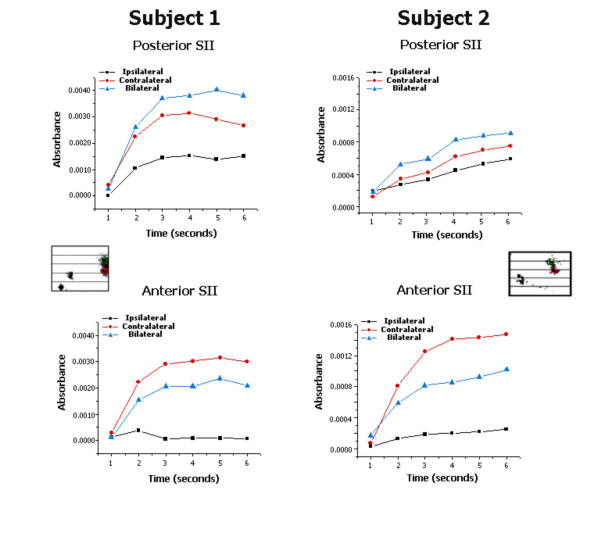
Graphs obtained from OIS data in the anterior and posterior SII cortical regions evoked by flutter stimulus on the central pad of 2 subjects. Figurines indicate regions of interest. (A) Top Panels: Time course of absorbance values from the posterior SII region obtained with ipsilateral, contralateral, and bilateral stimulus. Note that in this case, the absorbance evoked by the bilateral stimulus is larger than the response evoked by either the ipsilateral or the contralateral stimulus. (B) Bottom Panels: Time course of absorbance values from the anterior SII region obtained from data sampled during ipsilateral, contralateral, and bilateral stimulation. Note that the response evoked by the bilateral stimulus is smaller than the response evoked by the contralateral stimulus. Maximal differentiation of the time course of the response to the different stimulus conditions appears to occur between 1 and 3 seconds.